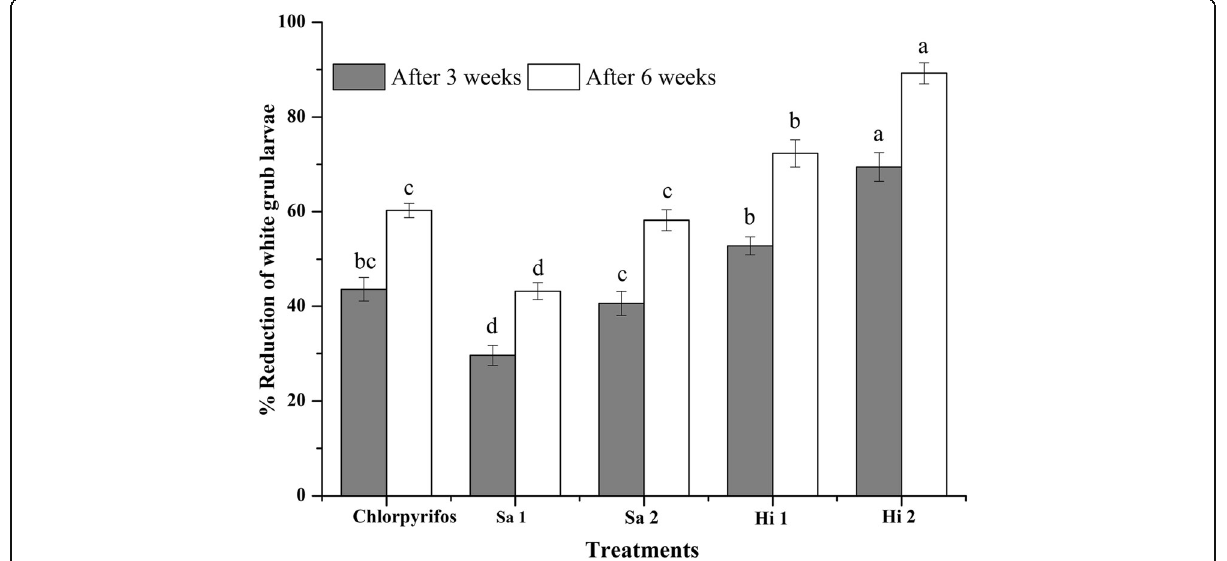
Fig. 1 Cumulative percentage reduction of third-instar larvae of Leucopholis lepidophora in areca nut field with different treatments 3 and 6 weeks after application in North Canara district, Karnataka, India during 2015 – 2017. Different letters on the top of error bars indicate statistically different values for different nematode concentrations using Tukey ’ s test ( P < 0.05). Bars = standard error. Sa, Steinernema abbasi ; Hi, Heterorhabditis indica